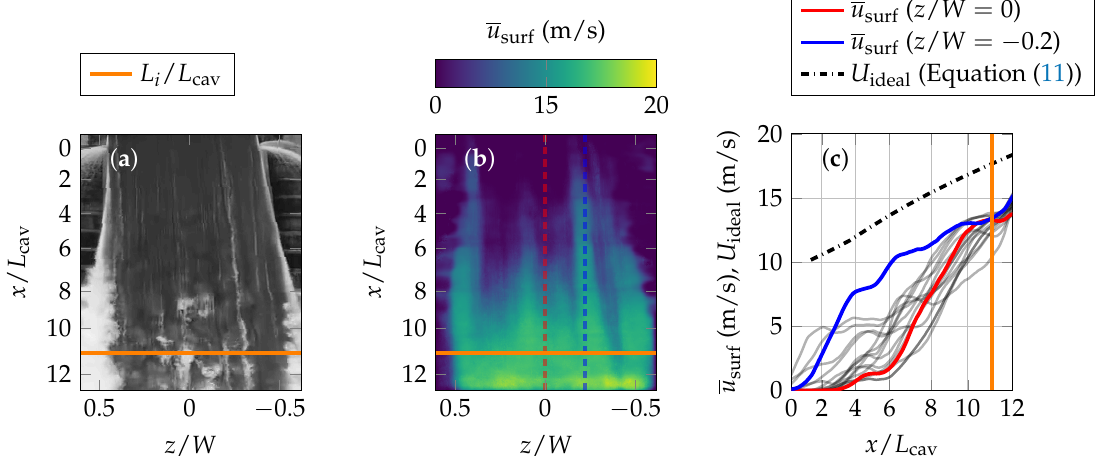
Figure 8. Streamwise air-water surface velocities on the prototype stepped spillway of Hinze Dam for d c / h = 2.6: ( a ) instantaneous raw-image recorded with a DJI phantom drone; ( b ) streamwise ( u surf ) air–water free-surface velocities; ( c ) development of streamwise velocities along the chute—comparison with idealized velocities calculated with Equation